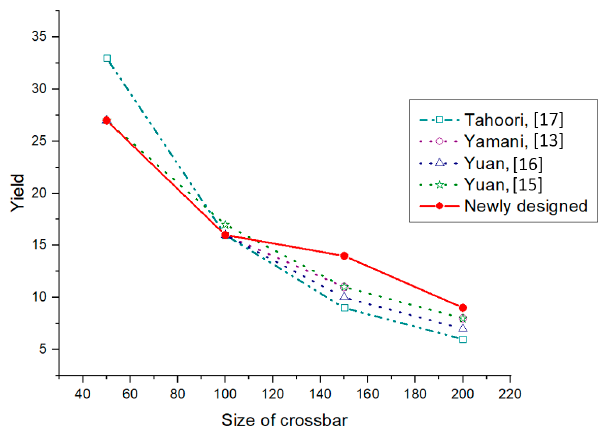
Figure 7. Yield comparison of defect-unaware fault-tolerant methods for a 5% stuck-at-off fault.